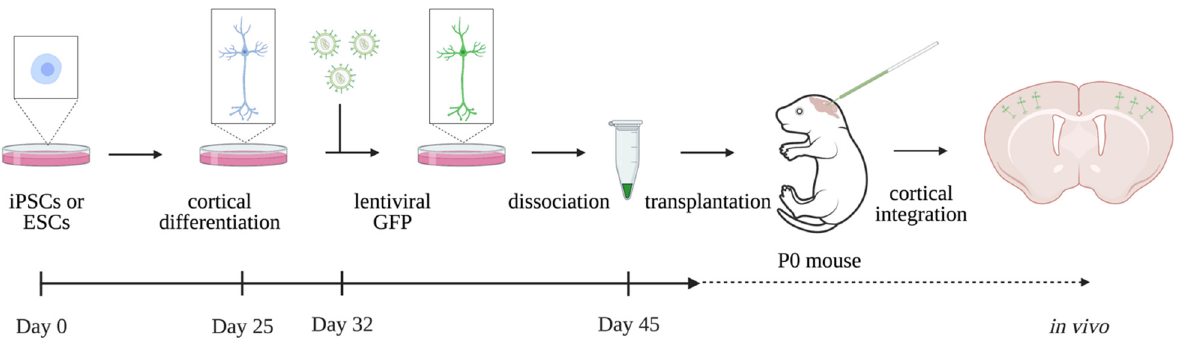
Figure 2. Experimental outline of in vivo xenotransplantation of human neurons. Human ESCs or iPSCs are differentiated in vitro into cortical neurons until day 45. Human neurons are transplanted into neonatal mice brains where neurons integrate into the cerebral cortex in vivo. Adapted with permission from Ref. [32]. © 2019, D. Linaro et al.